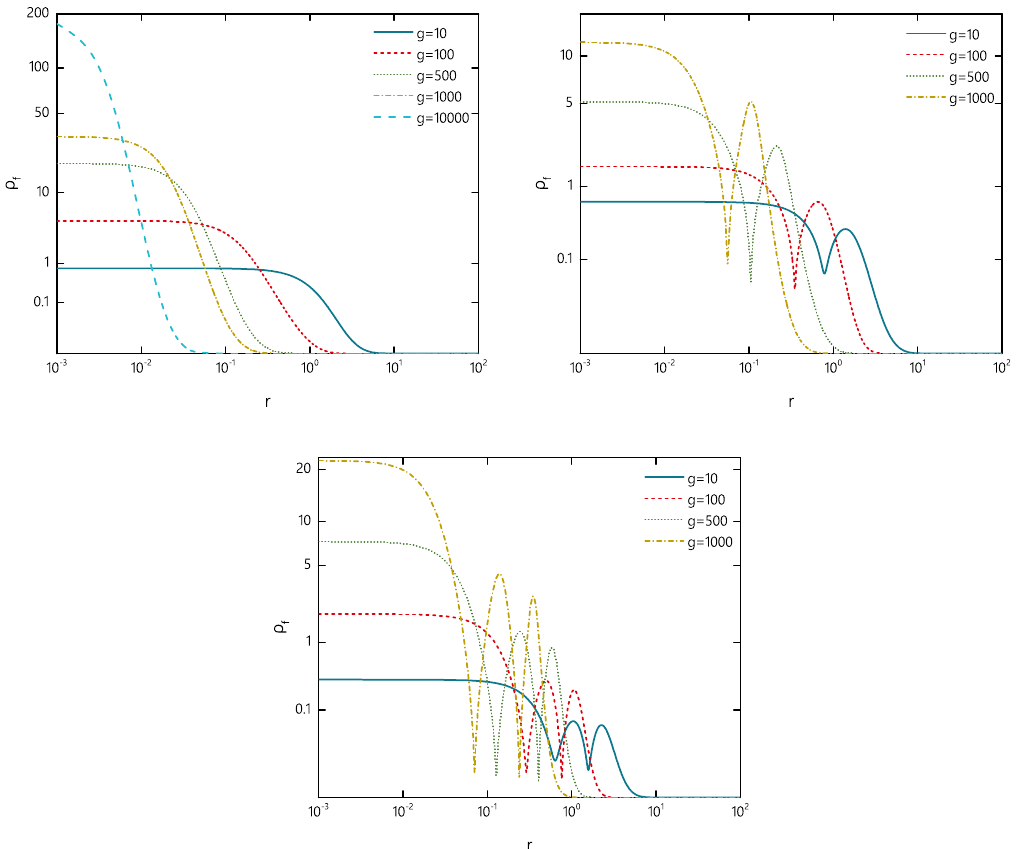
Figure 4 . Fermionic density distributions of the localizing modes A 0 (upper left plot), A 1 (upper right plot) and A 2 (bottom plot) as functions of the radial coordinate r for m = 0, κ 0 = 0 . 1 and several values of coupling constant g : 10